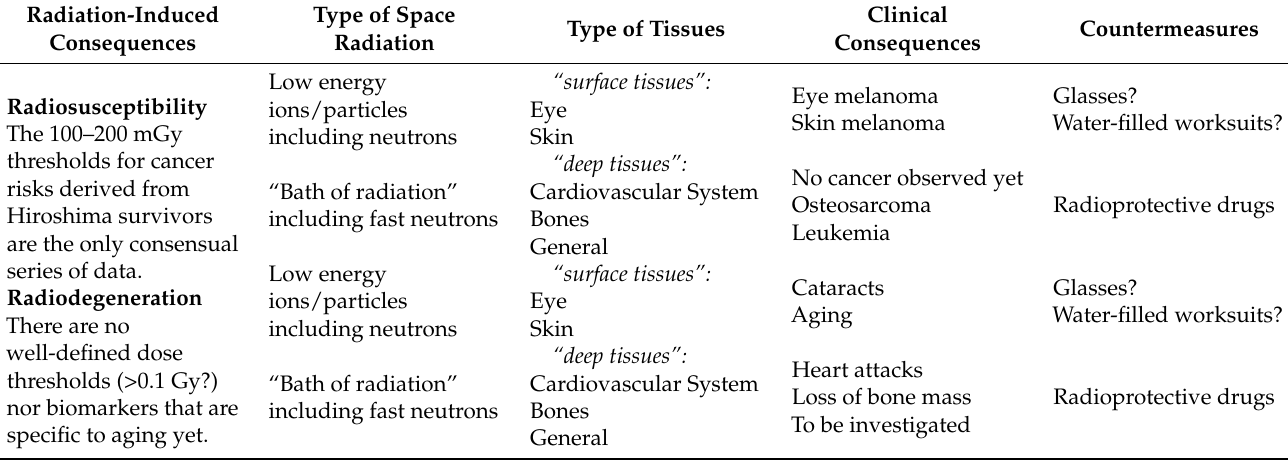
Table 3. Major radiation-induced risks for astronauts after long-term space mission in absence of severe solar events. Radiation-Induced